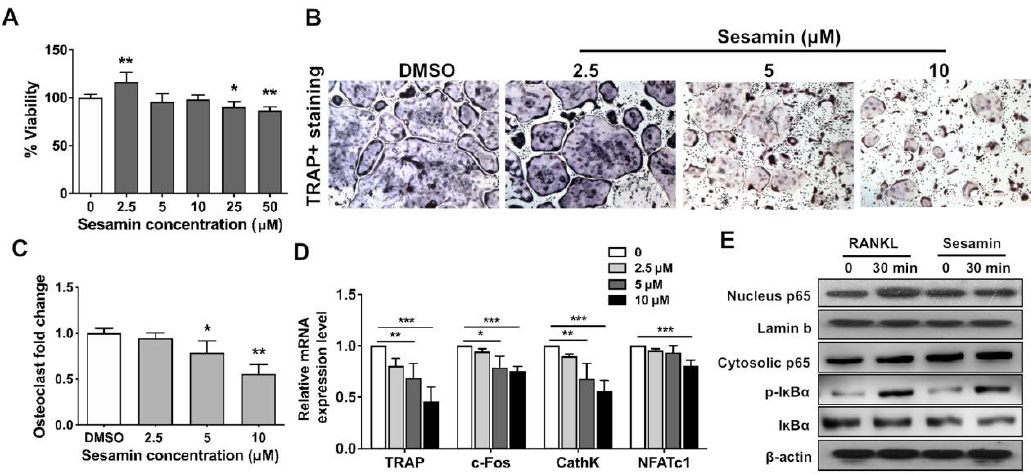
Figure 3. Sesamin inhibited osteoclastogenic differentiation of RAW264.7 cell by deactivating NF- κB signaling pathway. ( A ) . Cytotoxicity assay of RAW264.7 cells after treated with sesamin at different concentration for 3 days ( n = 6; * p < 0.05, ** p < 0.01). ( B ) . TRAP staining assay at Day 5 after RANCL-induced osteoclastogenesis was performed. ( C ). Quantitative data of osteoclast fold change ( n = 6; * p < 0.05, ** p < 0.01). ( D ) . The mRNA expression level of osteoclastogenic differentiation related markers measured by qRT-PCR ( n = 6; * p < 0.05, ** p < 0.01, *** p < 0.001). ( E ). Analysis of NF- κB/p65 nucleus translocation and IκBα phosphorylation levels by Western blot analysis in RAW264.7 cells after cells were treated with sesamin for 24 h and treated with RANKL for 30 min.